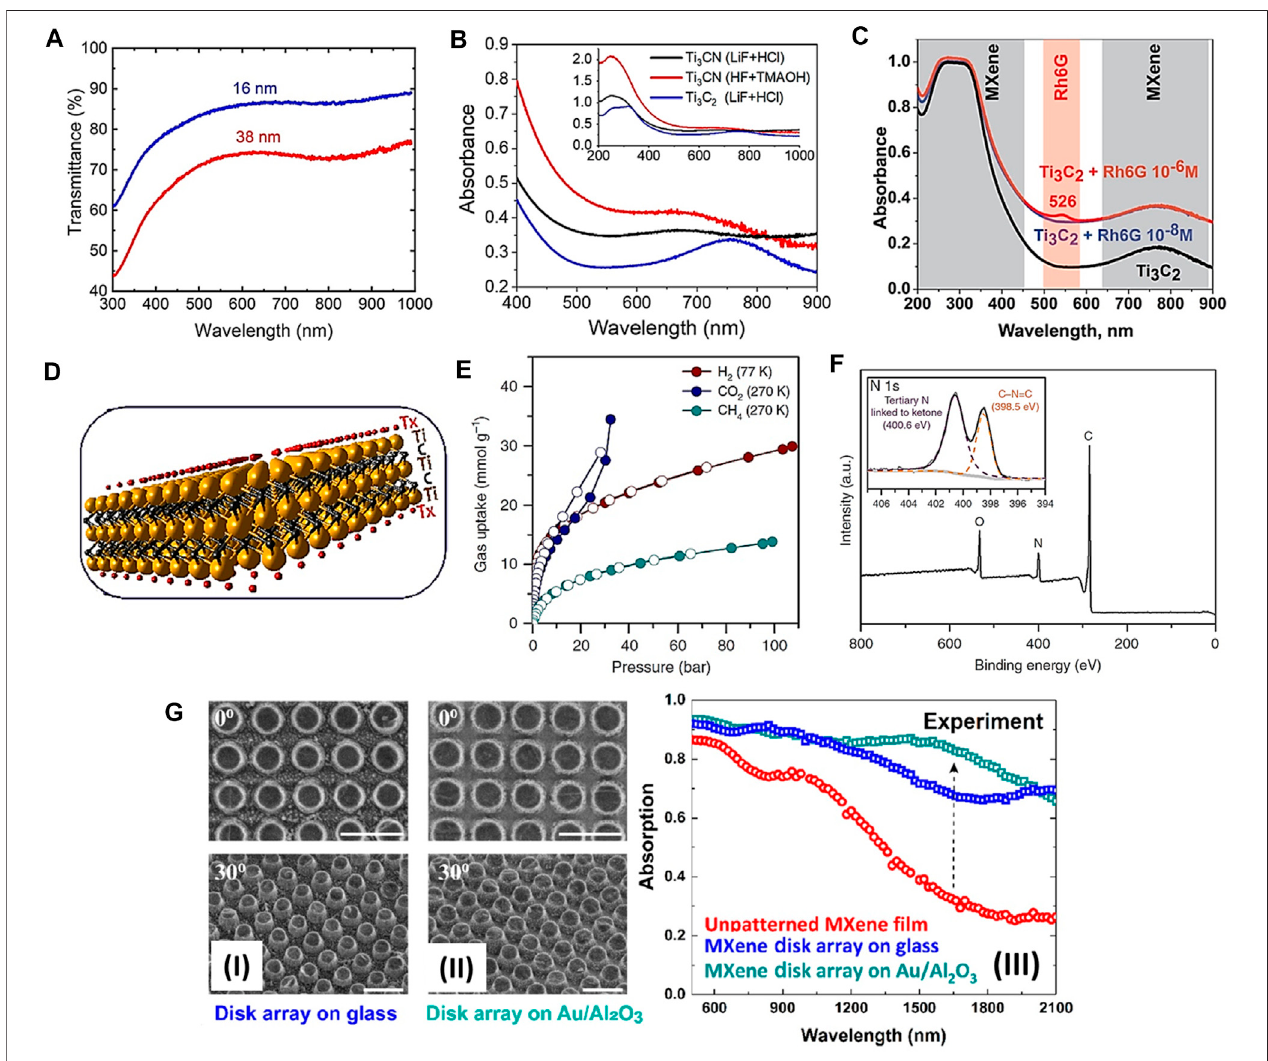
FIGURE 6 | UV-Vis absorption spectra of (A) Ti 3 C 2 T x fi lms with a thickness of 16 and 38 nm [adapted and modi fi ed from (Chertopalov and Mochalin, 2018)], (B) d-Ti 3 CNT x [adapted and modi fi ed from (Hantanasirisakul et al., 2019)], and (C) pristine Ti 3 C 2 T x in water and mixed with Rh6G dye [adapted and modi fi ed from (Sarycheva et al., 2017)]. (D) Structure of a single layer of Ti 3 C 2 T x [adapted and modi fi ed from (Chaudhuri et al., 2018)]. (E) High-pressure gas (H 2 , CO 2 , and CH 4 ) sorption isotherms of the V2D-BBL structure. (F) XPS survey of the V2D-BBL sample (inset: deconvoluted N1s spectrum) [adapted and modi fi ed from (Noh et al., 2020]. (G) SEM images collected from 0 ° (top) and 30 ° inclined angles (bottom) [adapted and modi fi ed from (Chaudhuri et al., 2018)].